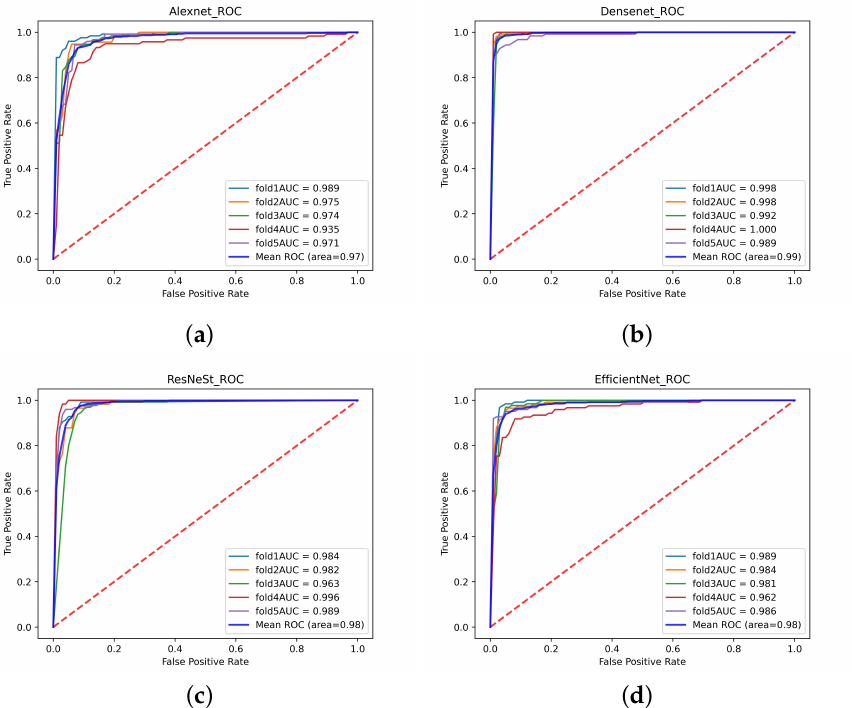
Figure 15. The ROC curve of the multi-modal data set. ( a ) Alexnet ( b ) Densenet ( c ) ResNeSt ( d )